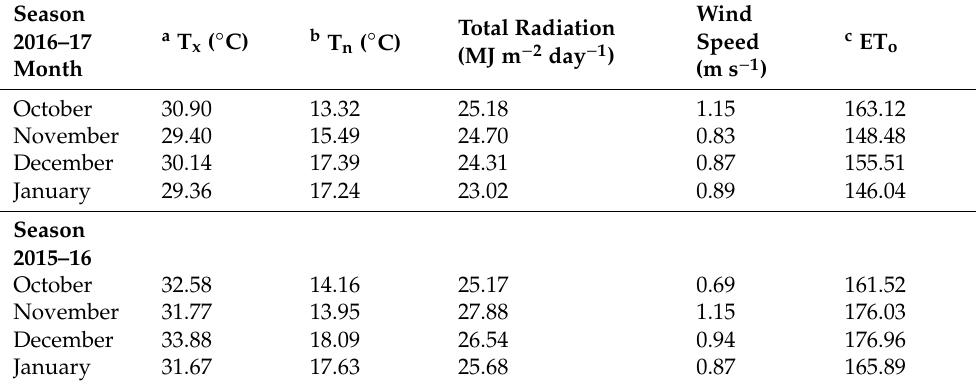
Table 2. Summary of monthly averages for climatic variables during the growing season of African leafy vegetables